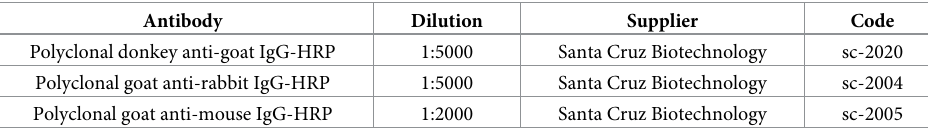
Table 2. Secondary antibodies used in western